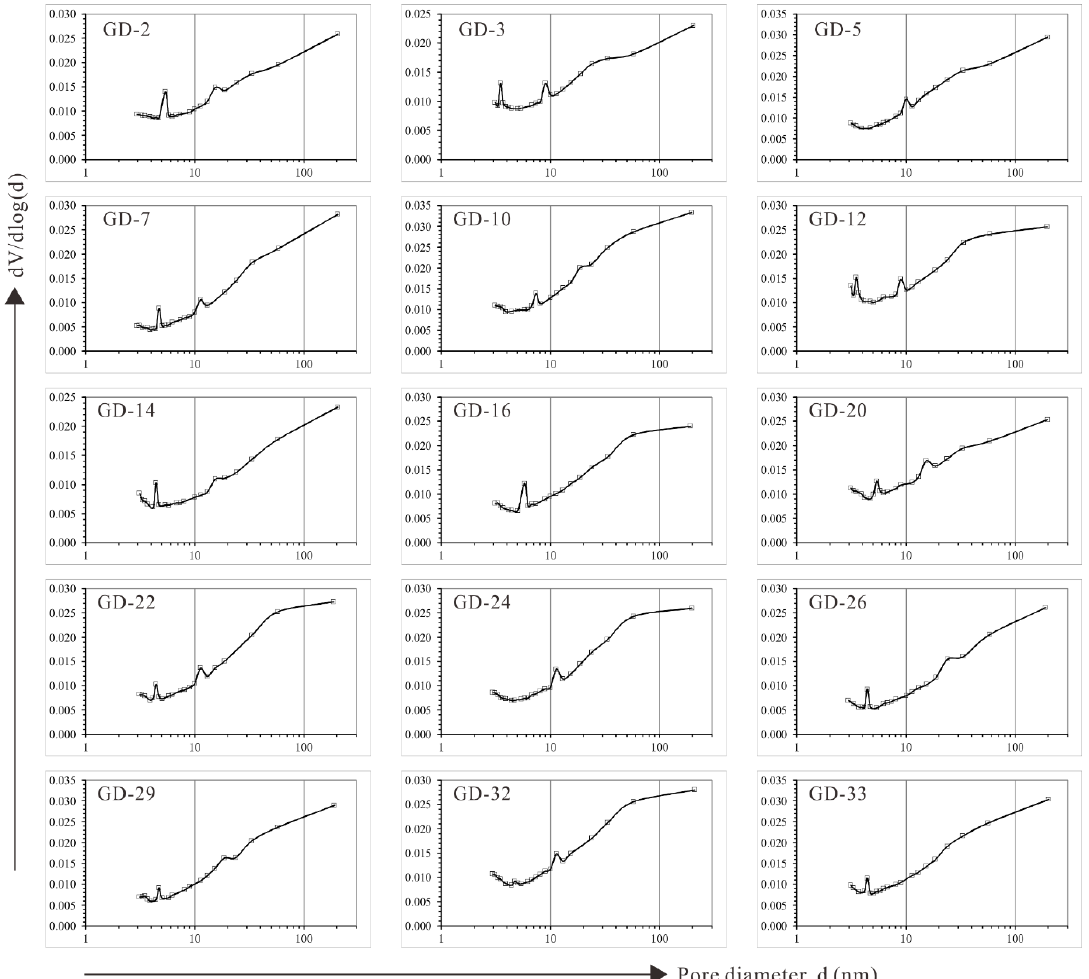
Figure 7. Barrett–Johner–Halenda (BJH) pore size distribution curves of the Dalong Formation